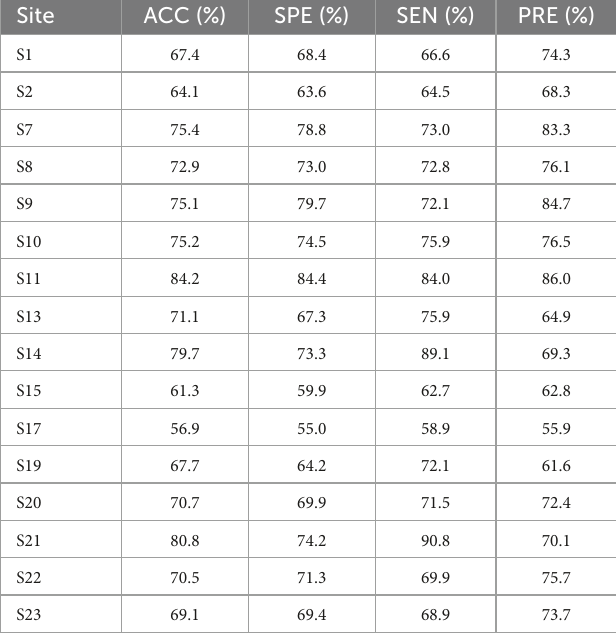
TABLE 7 Leave-one-site-out 10-fold cross-validation classification